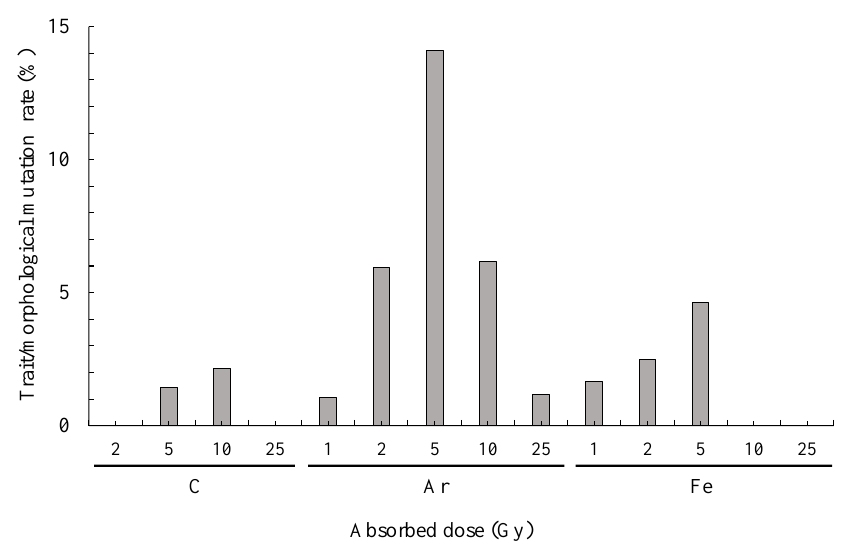
Figure 5. Trait/morphological mutation rate obtained by ion beam irradiation.